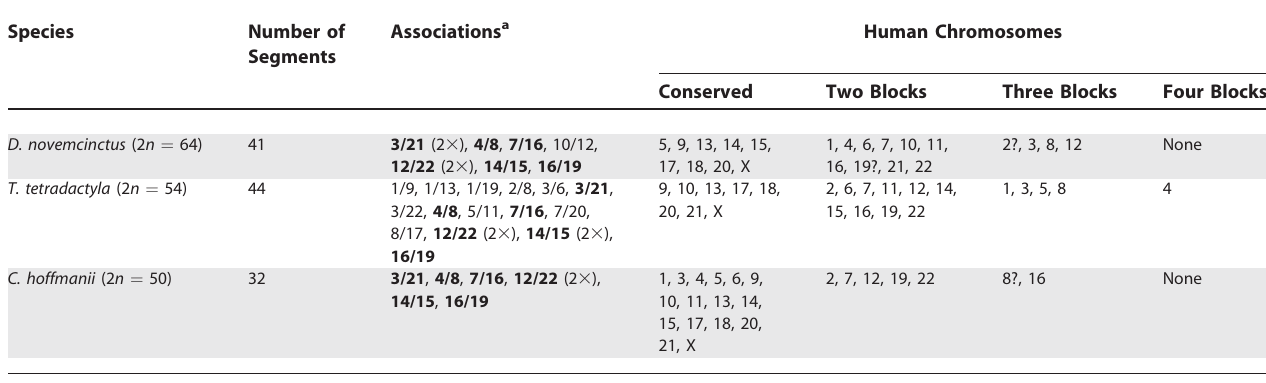
Table 1. Results of Chromosome Painting with Human Probes in Xenarthra